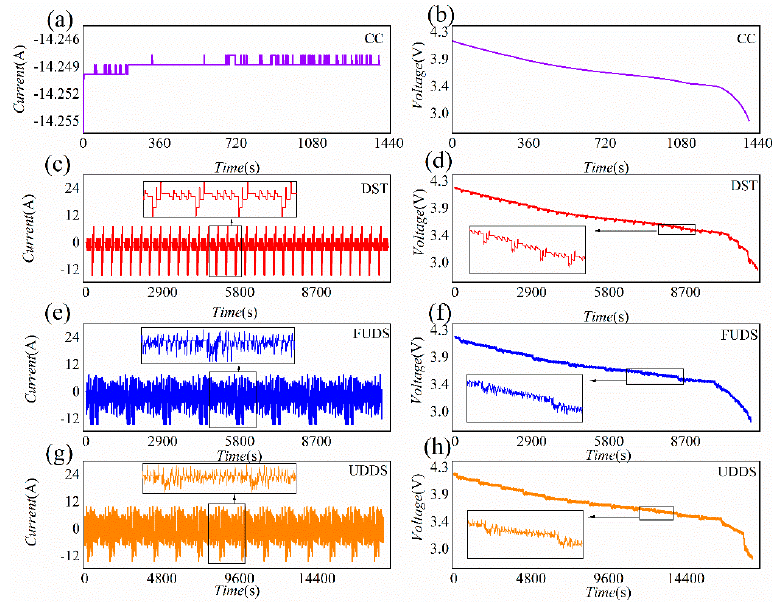
Figure 5. The curves of time vs. current under: ( a ) CC, ( c ) DST, ( e ) FUDS and ( g ) UDDS conditions, and the curves of time vs. voltage under ( b ) CC, ( d ) DST, ( f ) FUDS and ( h ) UDDS conditions. The specific composition of the combined driving cycle is shown in Figure 6.